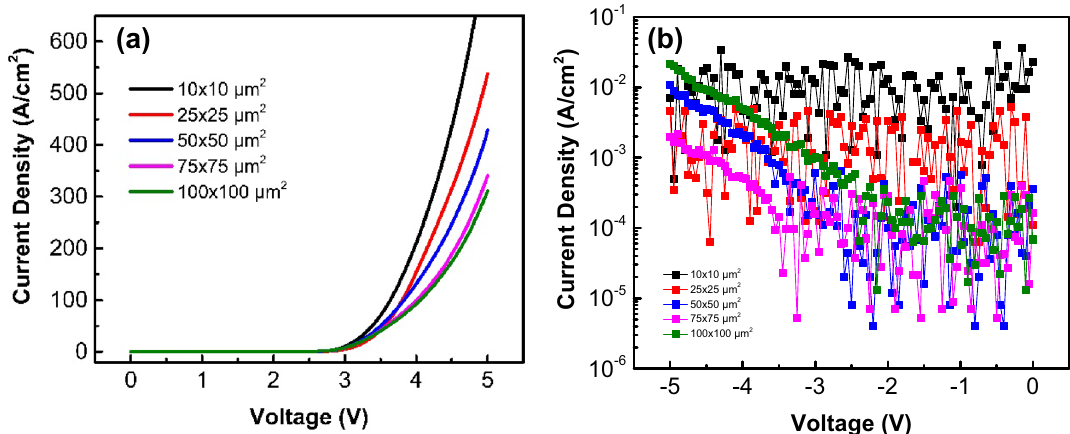
Figure 1. ( a ) Forward current density–voltage (J–V) characteristic for all chips and ( b ) leakage behavior for μ-LEDs with different sizes.